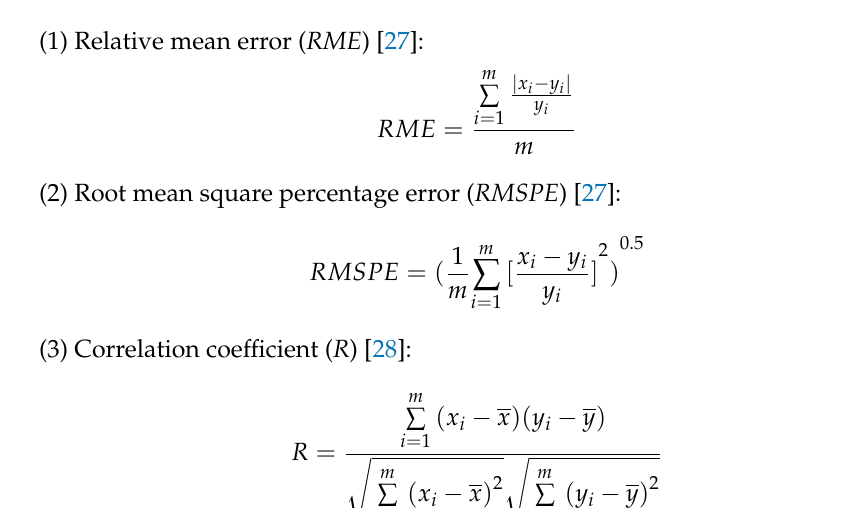
Figure 3. The location of the test station.